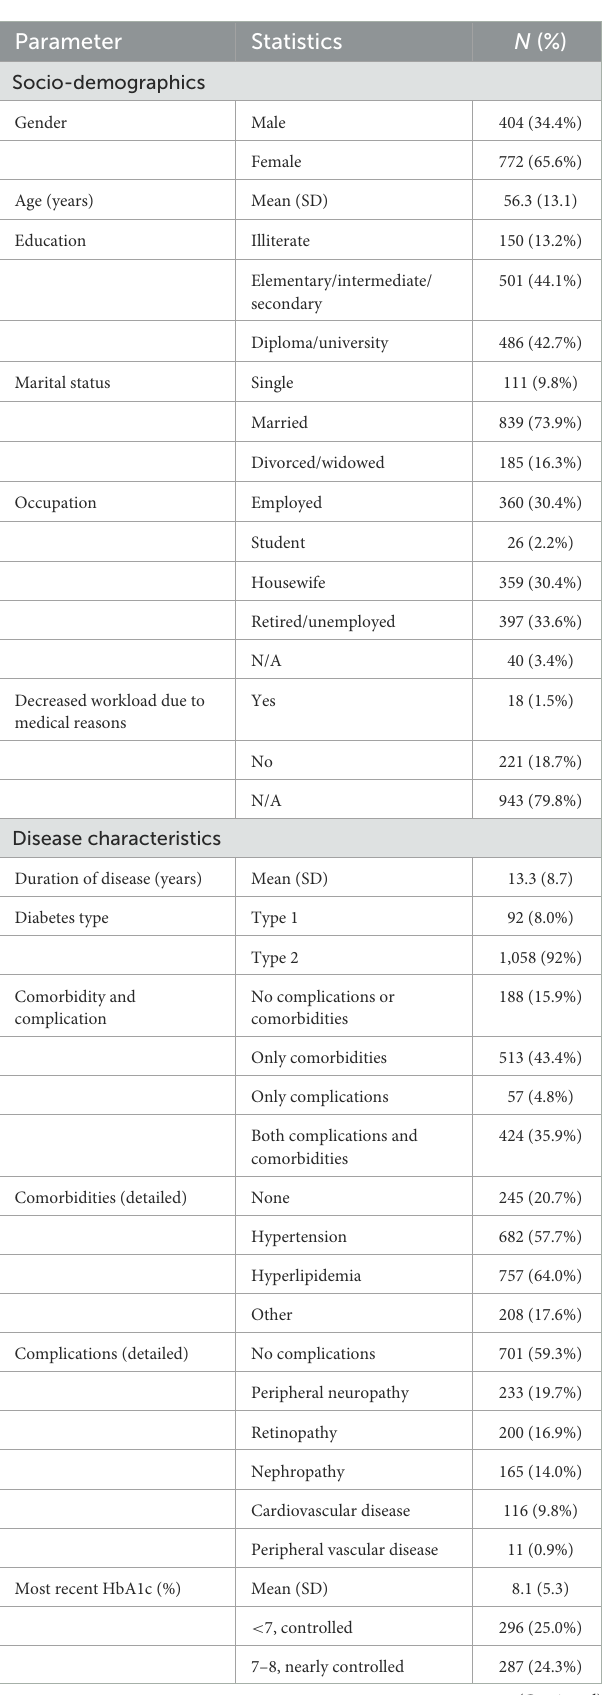
TABLE 2 Patients’ socio-demographic and clinical